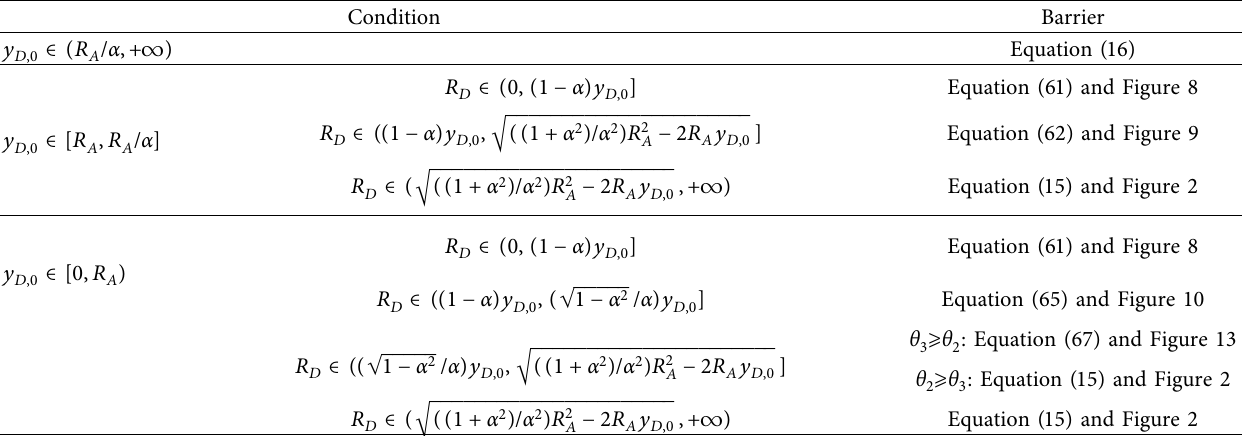
Figure 14: The local enlarged figure of the part of Figure 13 surrounded by the black box. Table 2: The barrier of the reach-avoid game with a time limit and detection range.